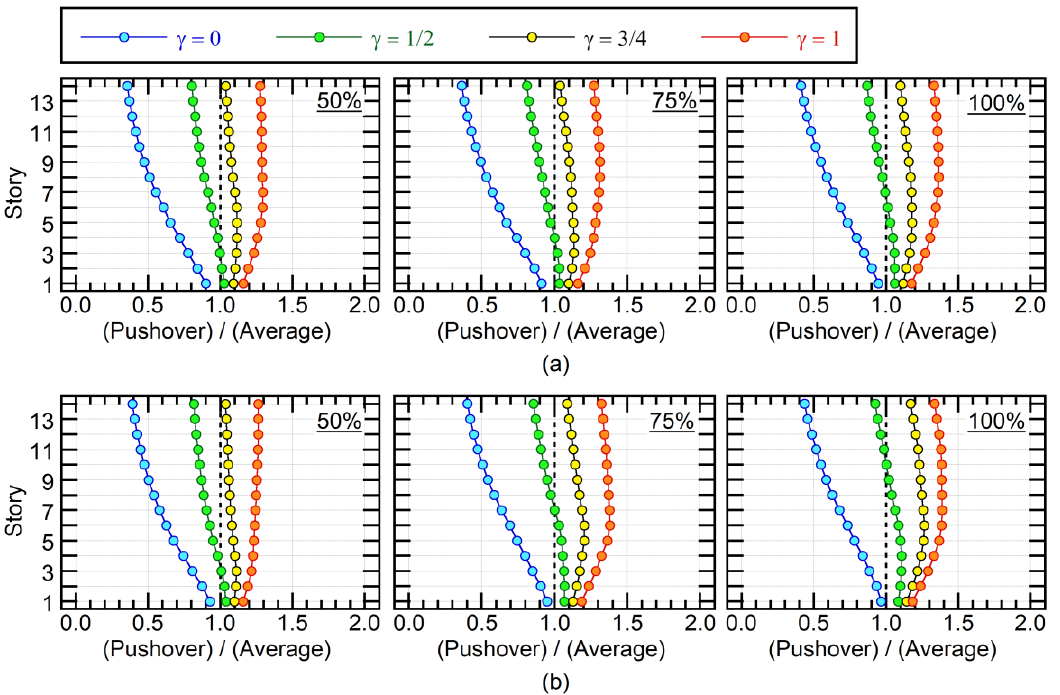
Figure 24. Accuracy of the pushover analysis results in comparison with the average values of time-history analysis (Model-14, shear force of column X 2 Y 2 ): ( a ) Art-S series and ( b ) Art-L series.